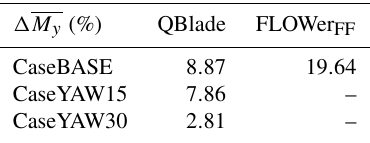
Table 13. Relative differences among the different simulation re- sults of the averaged flapwise bending moment with respect to the FLOWer solution including wind tunnel walls.